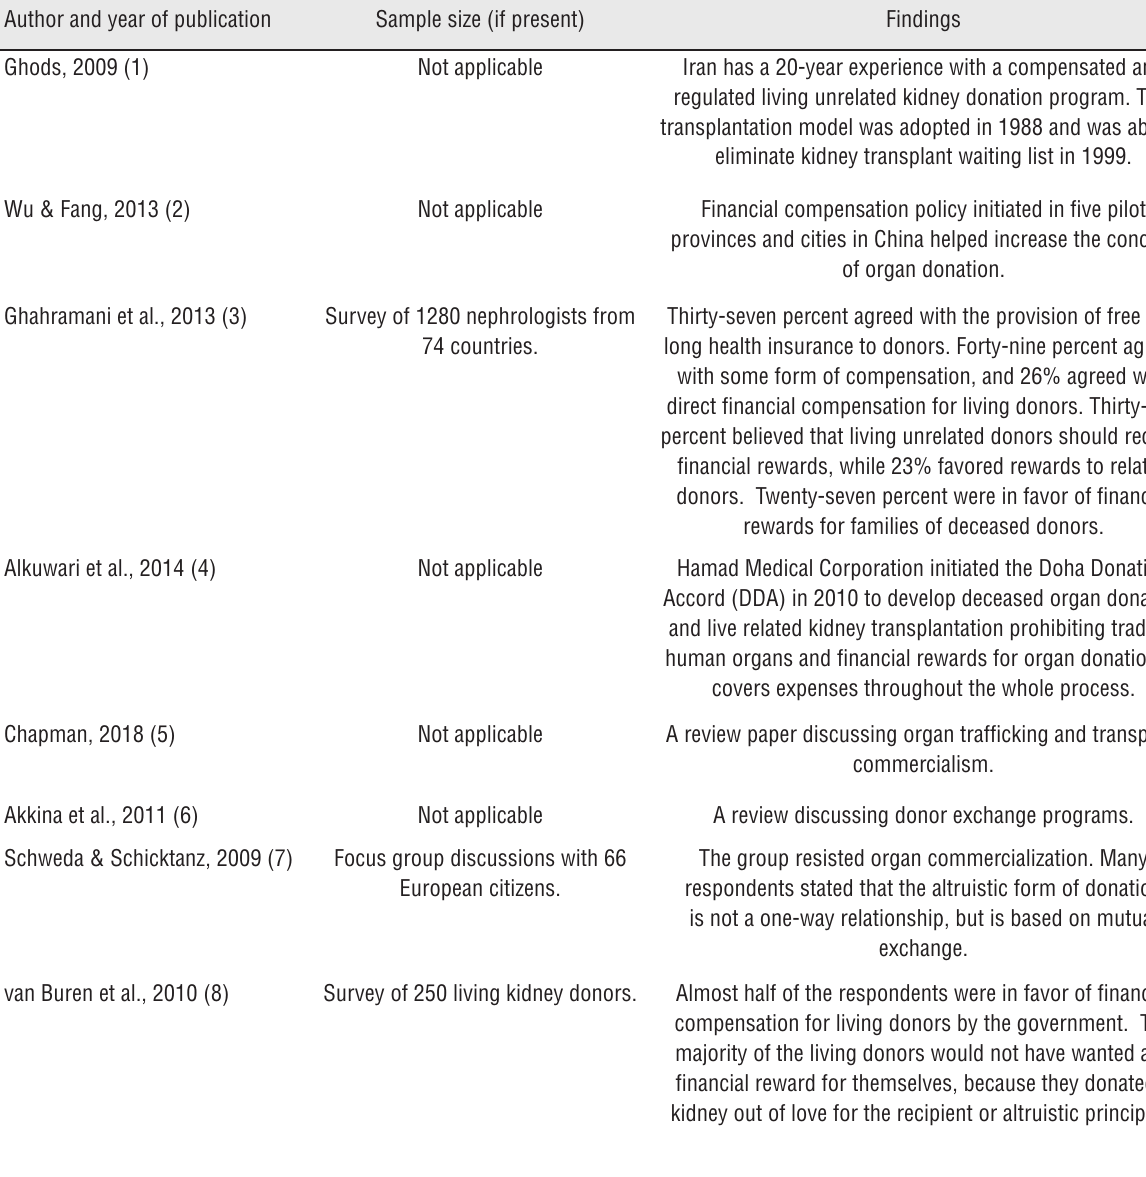
Table 1 - Summary of discussed